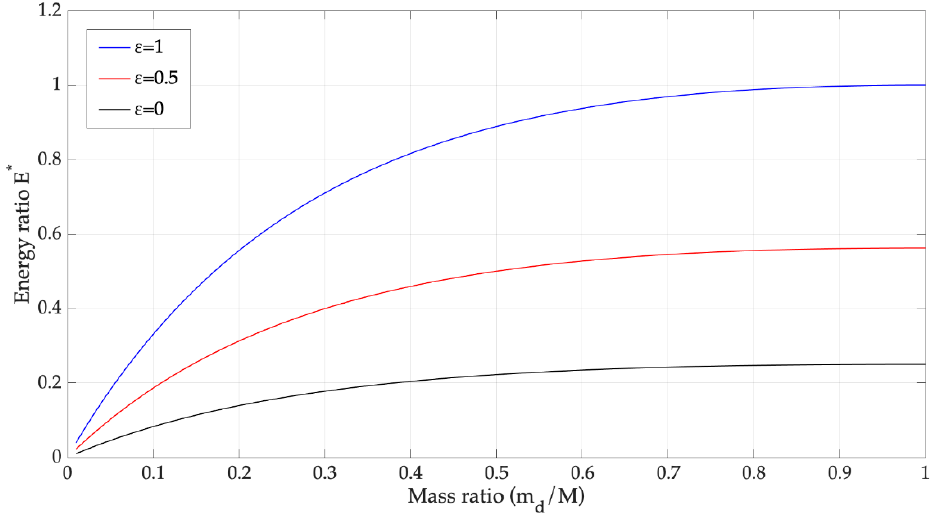
Figure 2. Ratio E ∗ against ratio µ = m d / M for some values of coe ffi cient of restitution ( ε). Ratio 𝐸 ∗ is plotted in Figure 2 against ratio 𝜇 = 𝑚 (cid:3031) 𝑀⁄ for some values of the coefficient of restitution ( ε).